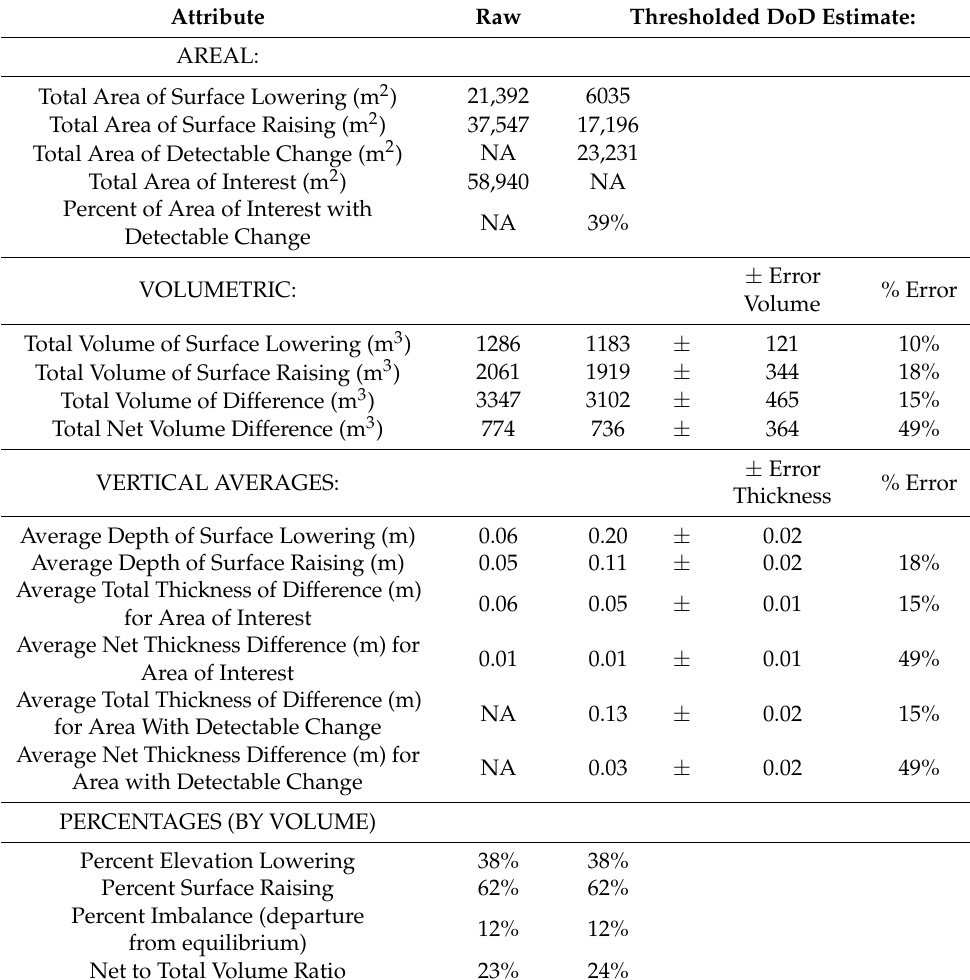
Table 1. Geomorphic changes of the Scott River alluvial fan area of interest after the August 2013 flood event calculated using the DoD method in GCD software. Uncertainty was calculated using a minimum detection level (minLoD) of 0.02